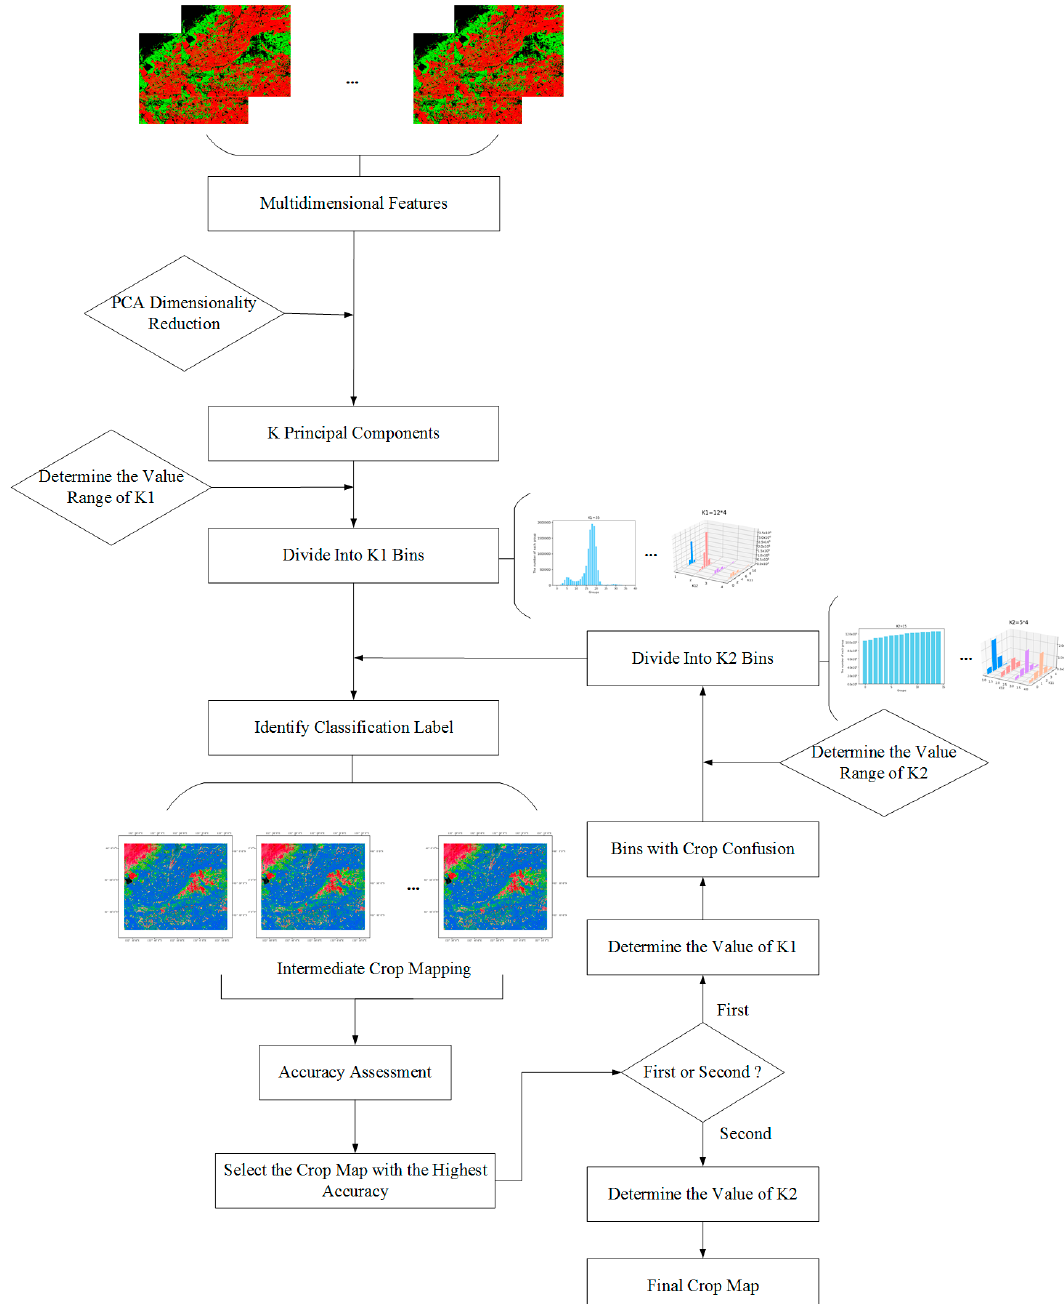
Figure 4. Workflow of the principal components isometric binning (PCIB) method.